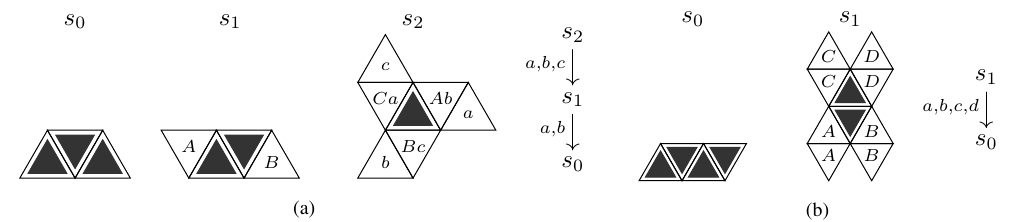
Figure 6: (a) A (1 , 1) proof sequence for T 3 , 1 . (b) A (2 , 3) proof sequence for T 4 , 1 .